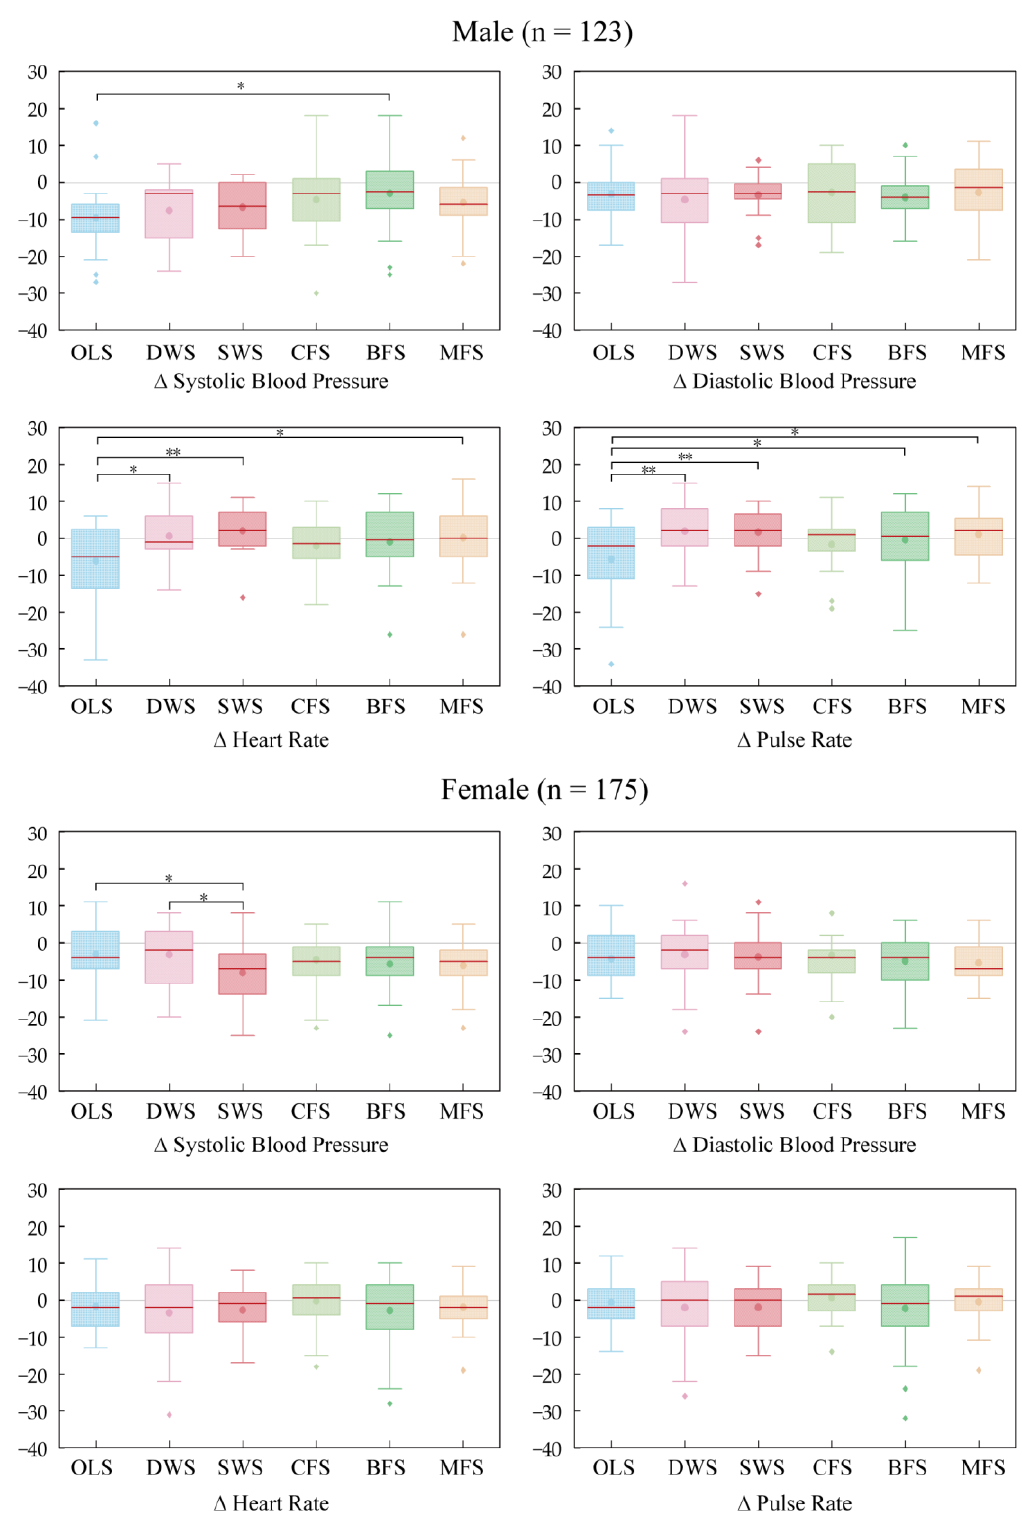
Figure 3. Differences in participants’ physiological response changes in the different forest landscape spaces. * p < 0.05. ** p < 0.01. OLS: overlook landscape space ( n = 49); DWS: dynamic water landscape space ( n = 48); SWS: static water landscape space ( n = 51); CFS: coniferous forest landscape space ( n = 50); BFS: broadleaf forest landscape space ( n = 51); MFS: mixed forest landscape space ( n = 49).